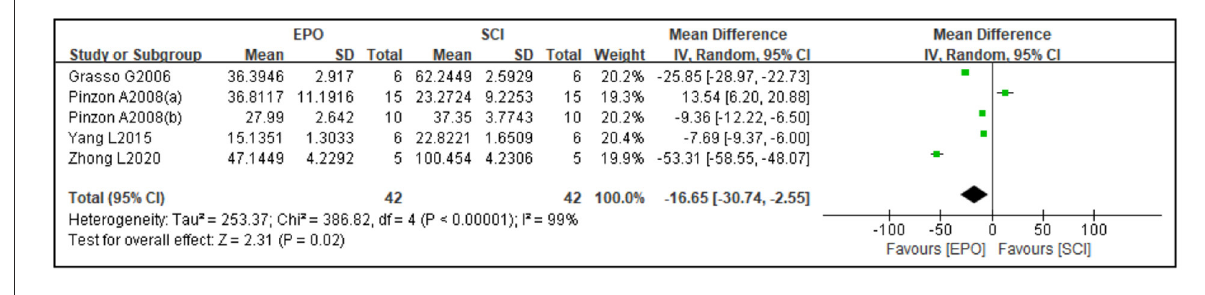
FIGURE3 Forest plot for the effects of EPO intervention on cavity area in rats with SCI. EPO, erythropoietin; SCI, spinal cord injury.